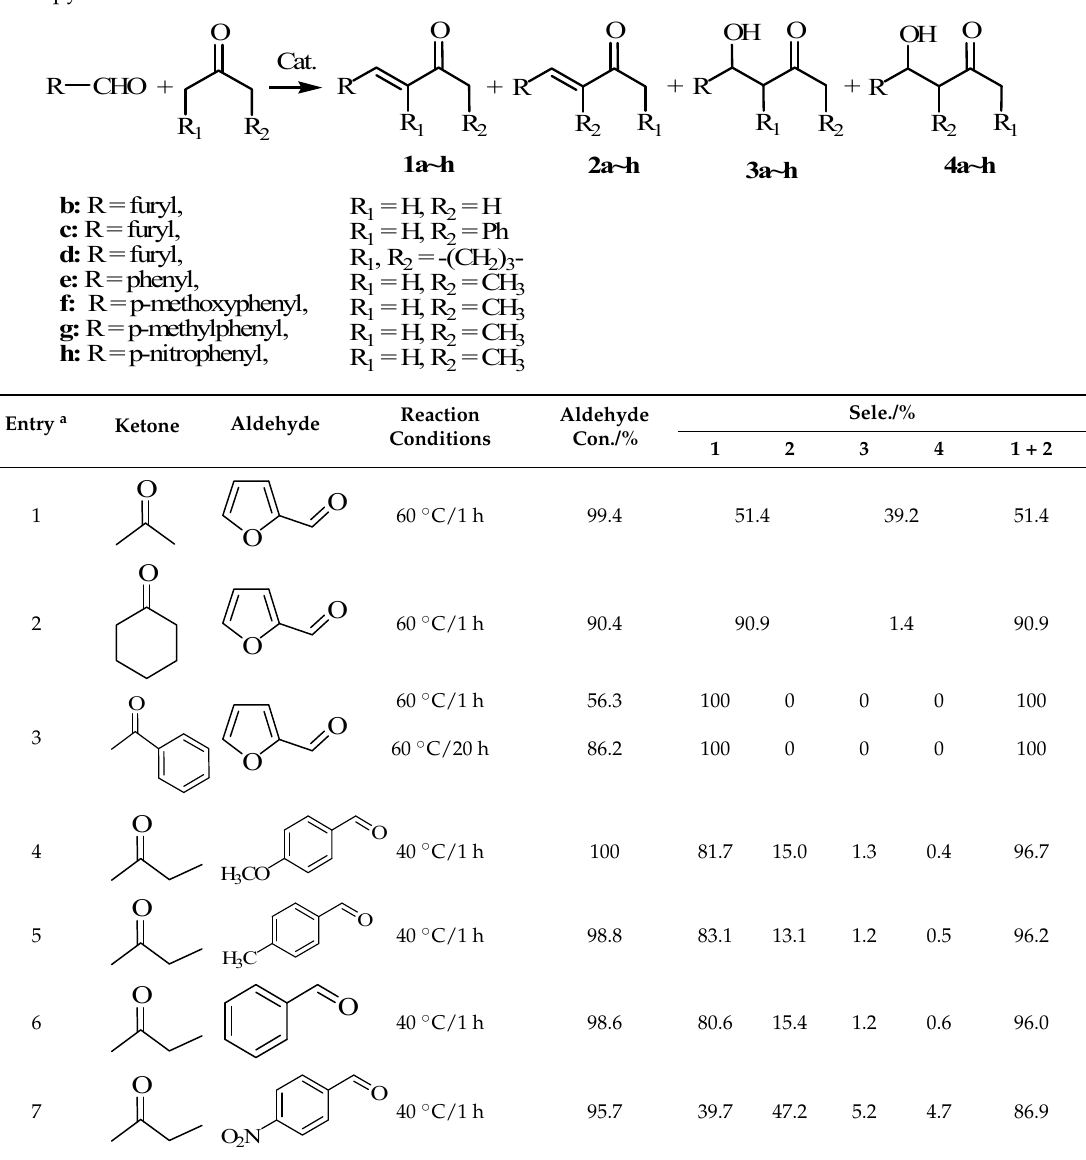
Table 4. Knoevenagel condensation of aromatic/heterocyclic aldehydes with methylene ‐ activated substrates catalyzed by 3 ‐ pyrrolidinamine. R CHO + R 3 R 4 Aldehyde Methylene ‐ Activated Substrates Time Product Yield/%